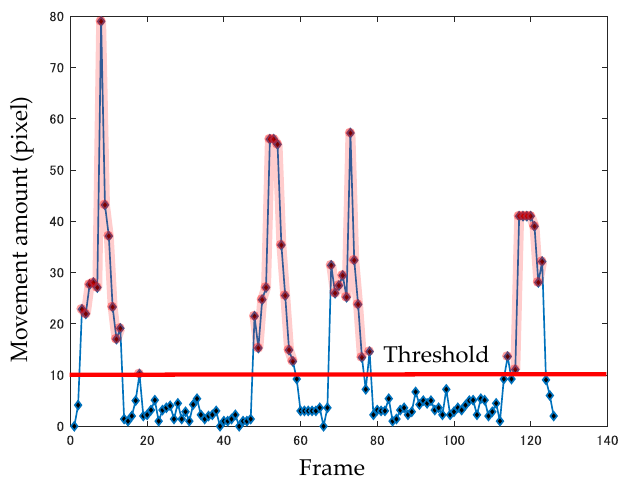
Figure 6. Angle of finger movement.